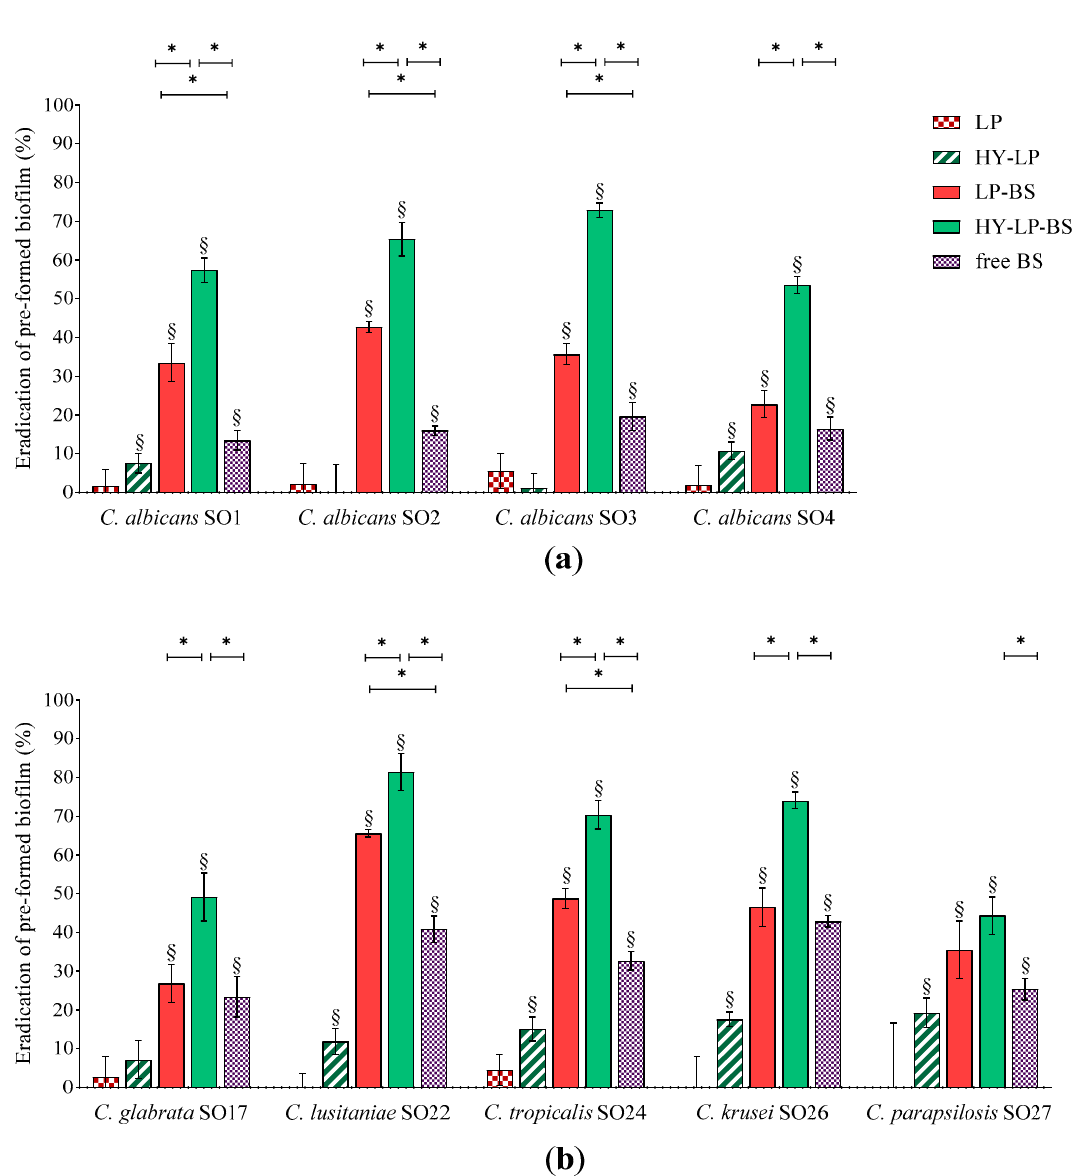
Figure 4. Anti-biofilm activity: dispersal of pre-formed ( a ) C. albicans and ( b ) non- albicans biofilms. Results are expressed as eradication percentage (mean ± SD, n = 5). The statistical significance with respect to untreated control was reported, §: p < 0.01. Statistical differences between BS, LP-BS and HY-LP-BS were also calculated, *: p < 0.05.